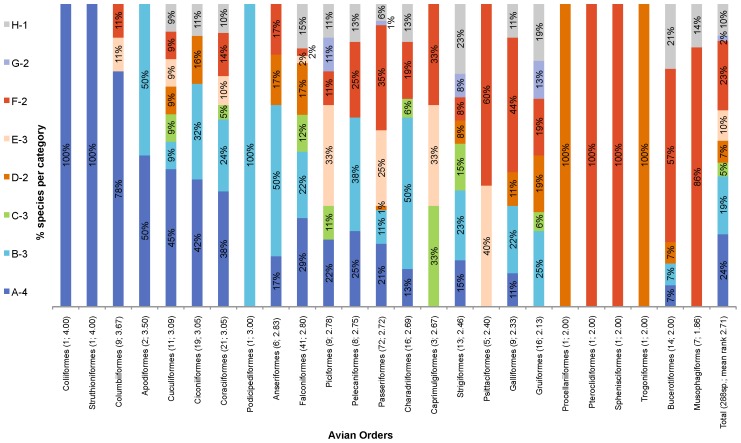
The proportion of traded bird species per order in the eight Rabinowitz classes (excluding PALs and exotics).The number of species per order and the mean rarity rank (derived from rank scores in Table 1) are given in parentheses. The orders are listed from most common to most rare (left to right respectively).